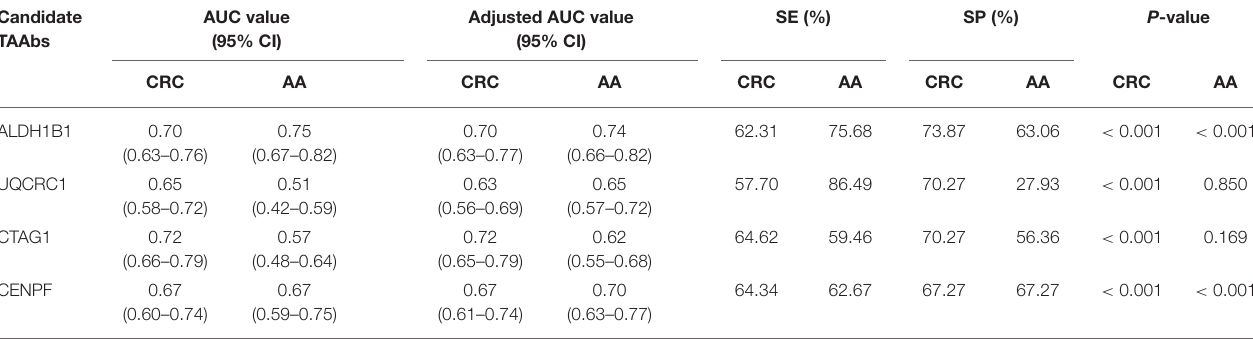
TABLE 1 | Detection performance of single tumor-associated autoantibodies in the detection of colorectal cancer and advanced adenoma determined by ELISA. Candidate